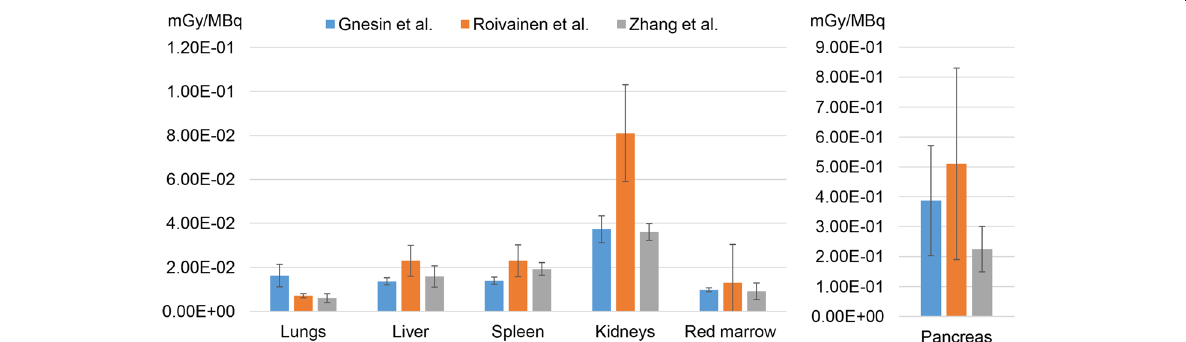
Fig. 4 Dosimetry comparison between our study and those of Roivainen et al. [30] and Zhang et al. [34] based on OLINDA/EXM 1.0. The absorbed dose estimations reported in this figure are based on either a 3.5-h urinary voiding cycle (our study and that of Roivainen et al. [30]) or on a 1-h voiding cycle (Zhang et al. [34]). It should be noted that, for the organs reported, variations of urinary voiding cycle do not produce significant changes of absorbed dose estimations. Error bars represent ±